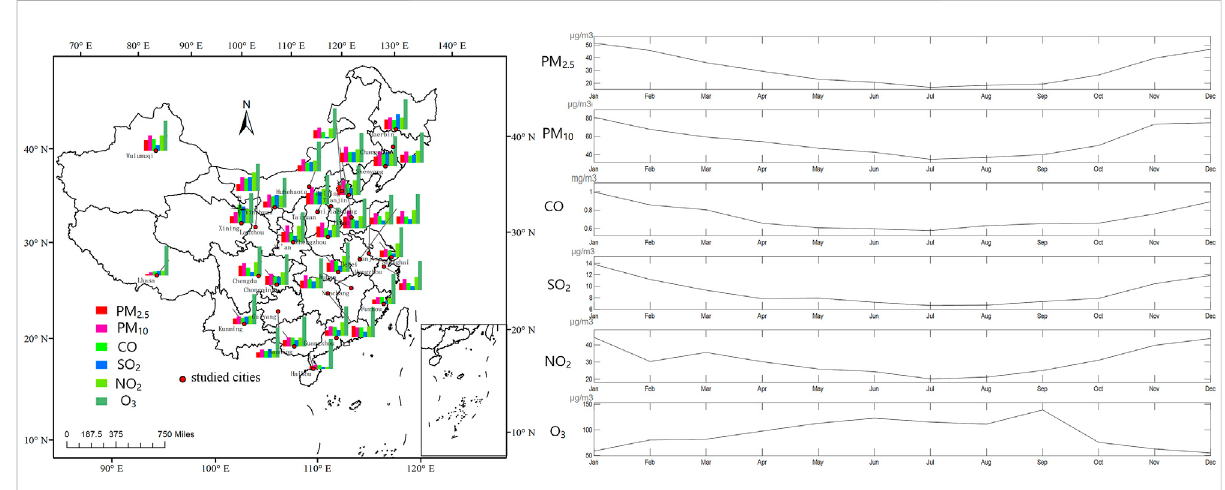
FIGURE 6 Spatial distribution of six air pollutants at 31 provincial cities in China and temporal distribution of pollutants for 12